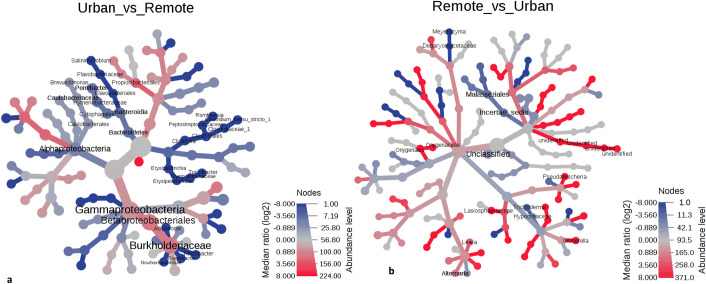
Spatial variations at various taxonomic levels presented on a differential heat tree (a) Bacterial and (b) Fungal communities. Only the significantly different taxonomic ranks are shown on the tree. (dark shade-remote population; light shade-urban communities).